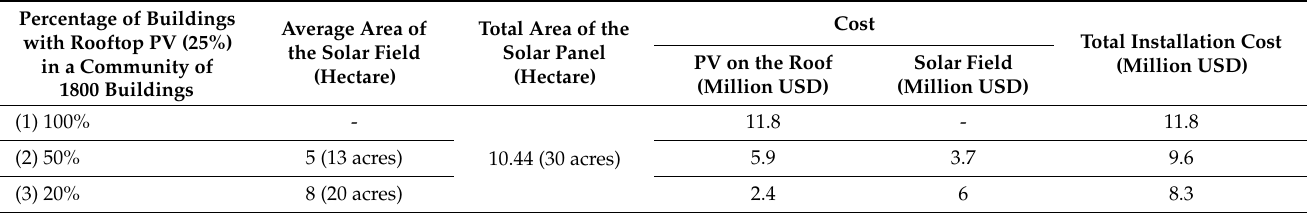
Table 11. Optimized community solar solution for